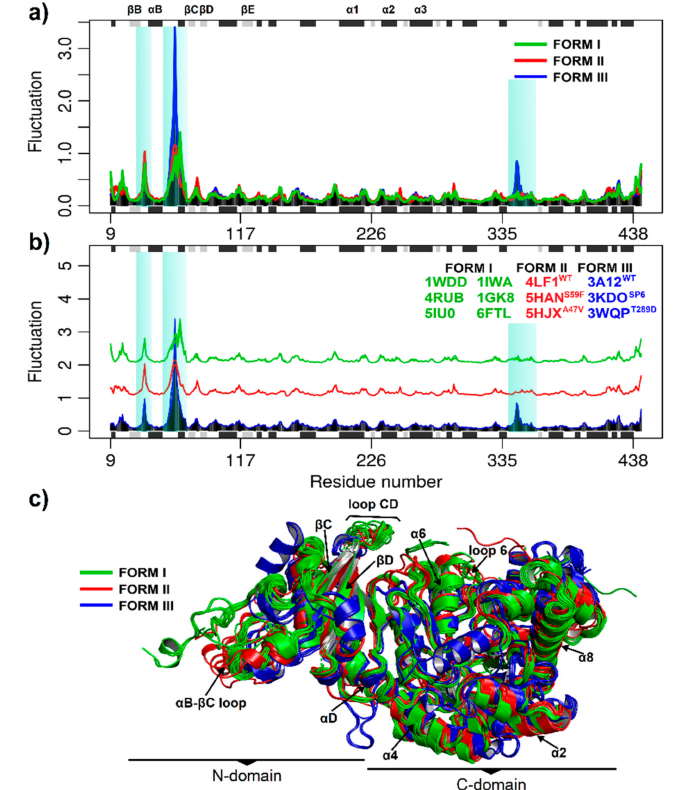
Figure 4. Normal mode analysis. ( a ) Consensus fluctuations of RuBisCO forms I, II and III. α -helices are in black and β -strands in gray; ( b ) Consensus fluctuations among species. In Form I are O. sativa (1WDD), N. tabacum (4RUB), A. thaliana (5IU0), C. reinhardtii (1GK8), G. partita (1IWA) and S. marinoi (6FTL). In form II are R. palustris with 1 wild-type (4LF1 WT ) and 2 mutants (5HJX A47V and 5HAN S59F ), and in form III are T. kodakarensis with 1 wild- type (3A12 WT ) and 2 mutants (3KDO SP6 and 3WQP T289D ); ( c ) Monomeric structure of RbcL. The monomer is divided into two domains: the N-terminal domain and the C-terminal domain. Loop α B- β C, loop CD, loop 6 and α 6 are indicated. The different colors indicate Form I (green), II (red), and III